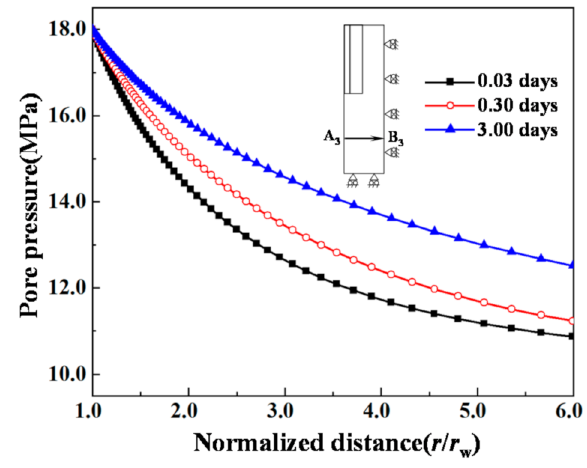
Figure 5. Excess pore pressure near the wellbore along A 3 B 3 (formations) with time.